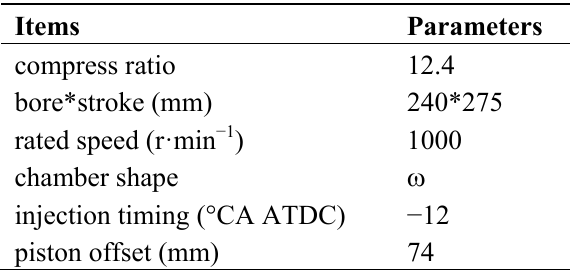
Table 1. Parameters of the engine.